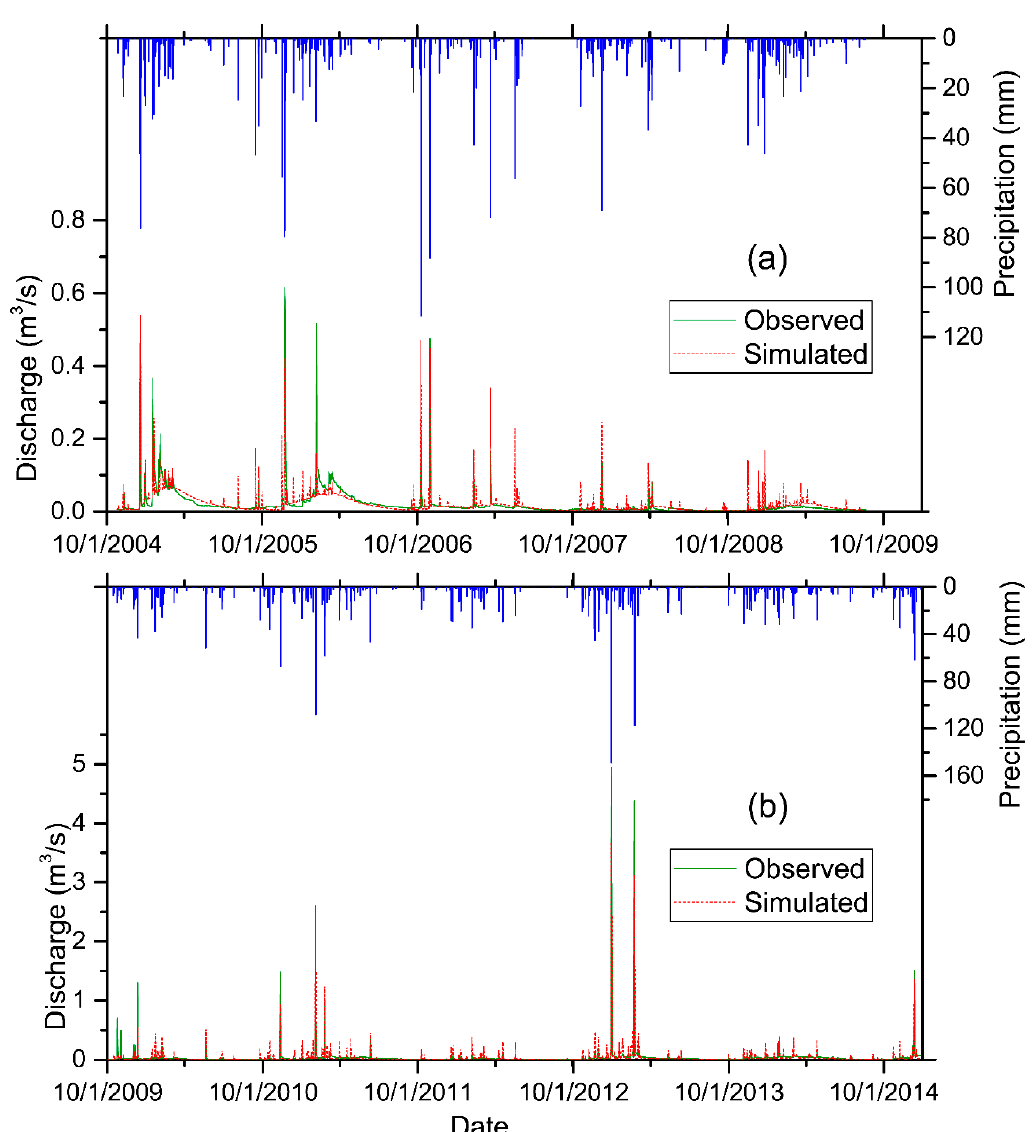
Figure 2. Graphical representation of the observed vs. the simulated daily discharge obtained by the most suitable (second) calibration approach for ( a ) the pre-fire period and ( b ) the post-fire period. The corresponding daily rainfall depths are also presented.